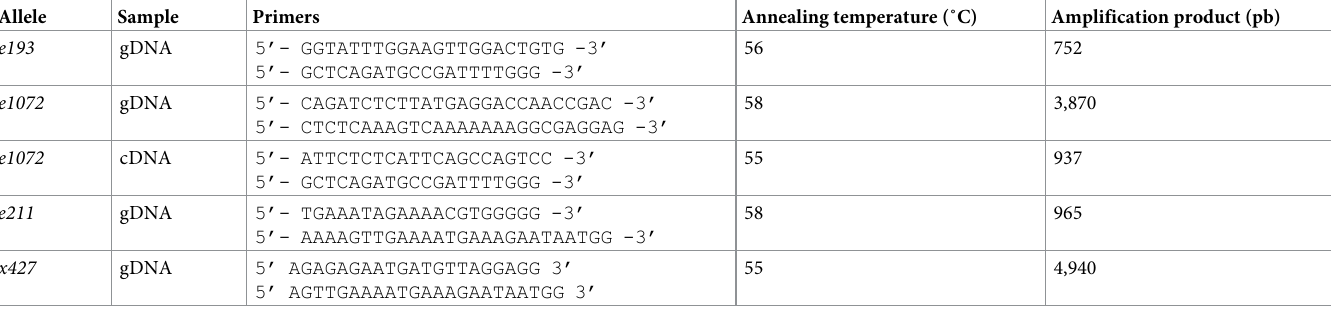
Table 1. Primer sequences and PCR conditions for mutation analysis of alleles in lev-1 and unc-29 .